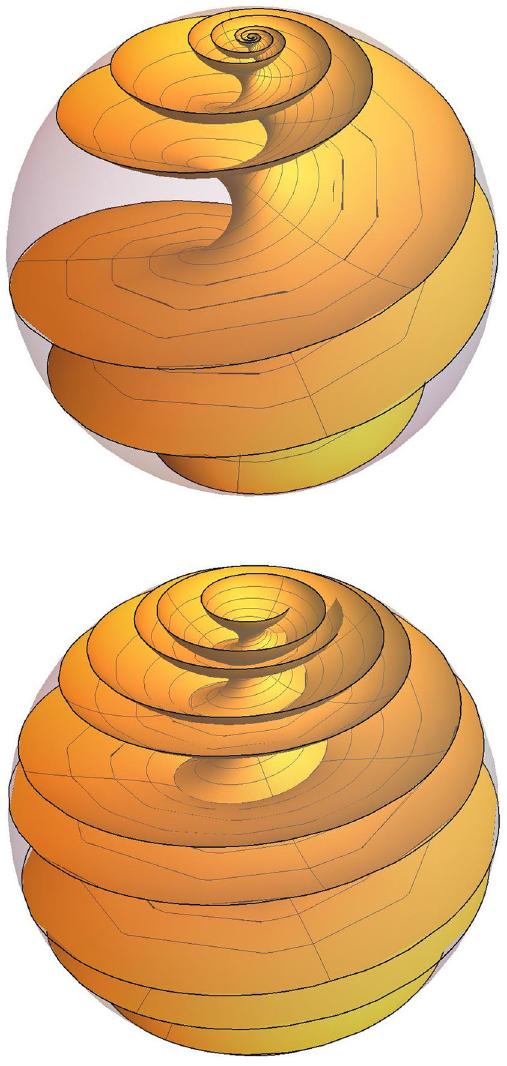
Fig. 4 The elliptic minimal surface in global coordinates for two dis- tinct selections of the parameters E and ℘ ( a 1 )